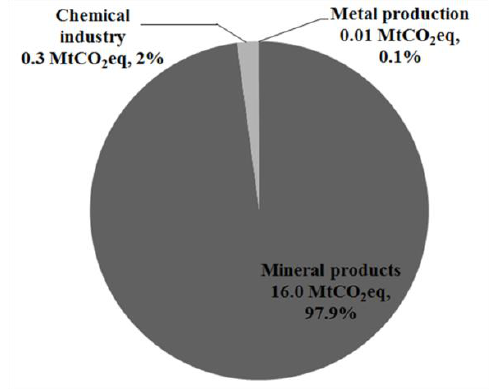
Fig. 3. Thailand’s GHG emissions in 2000, by the industrial